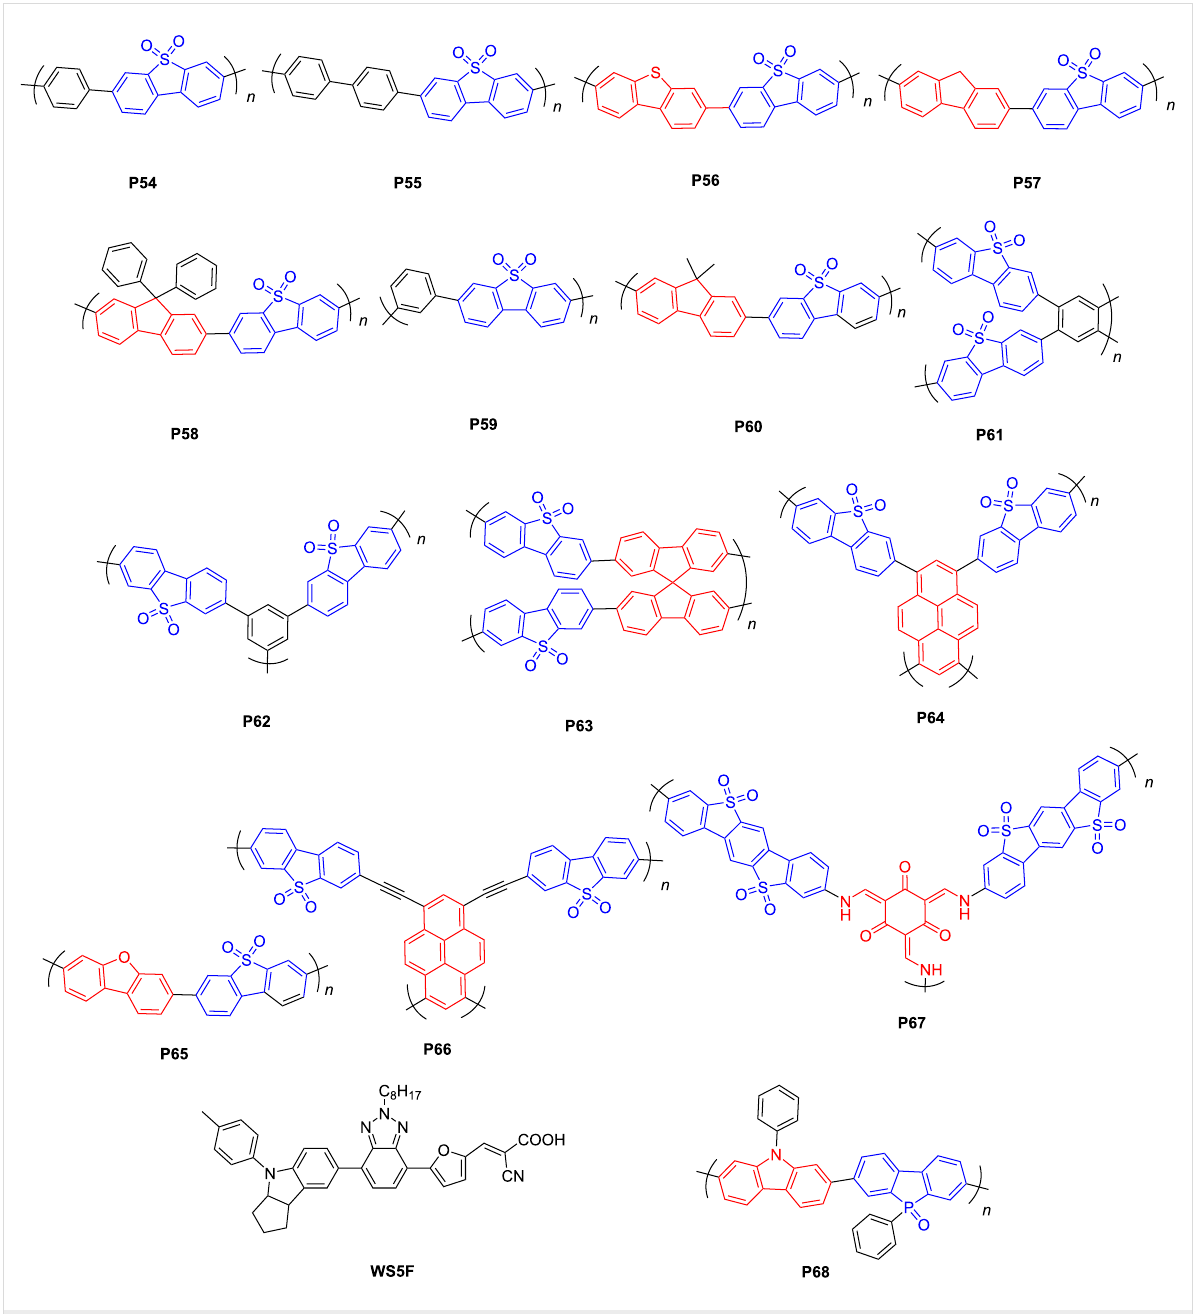
Figure 8: Schematic representation of structures of dibenzothiophene- S , S -dioxide-based CPs.